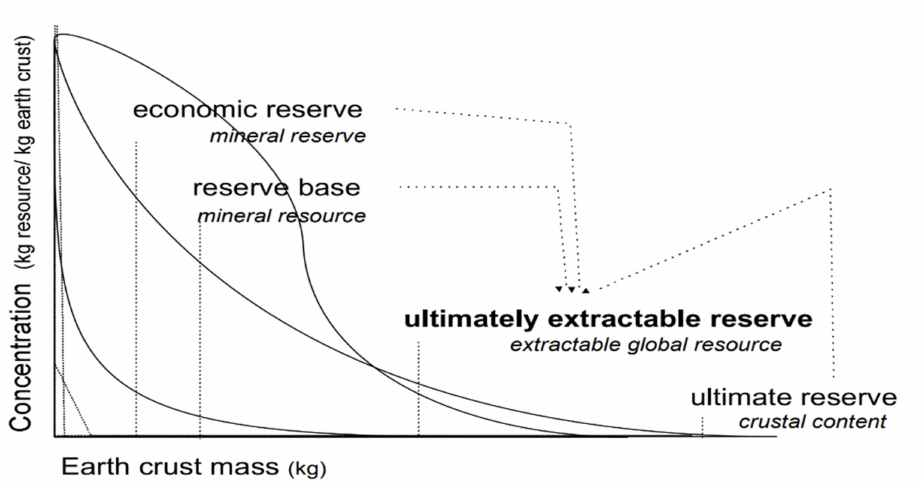
Figure 1. Usage amounts and distributions of various theoretical resources in the earth’s crust